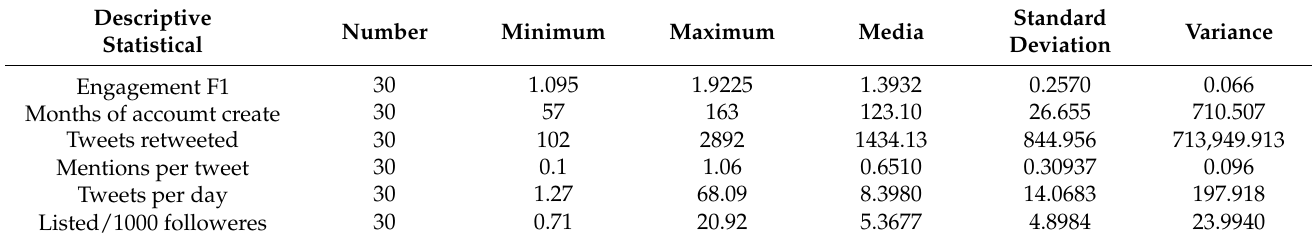
Table 3. Descriptive analysis of variales.